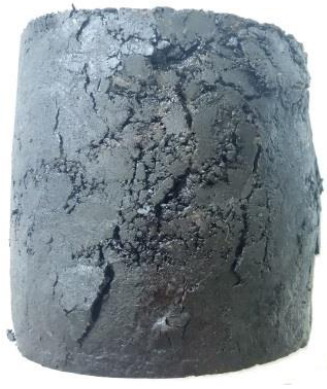
Figure 4. Shear failure of specimen.